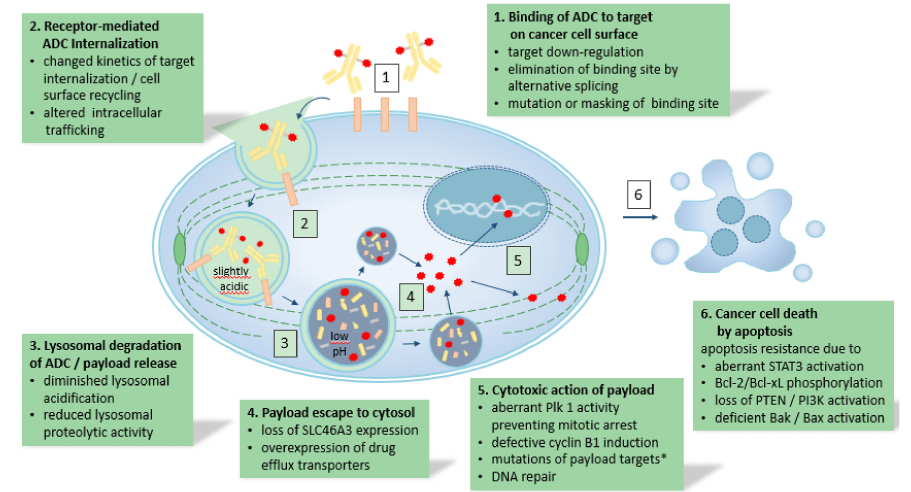
Figure 1. The sequence of events that have to occur for an ADC to exert its cytotoxic action and mechanisms of resistance that can affect them. * such mutations are known to play a role in resistance to taxanes, but the same has not been shown yet for ADCs with microtubule-disrupting